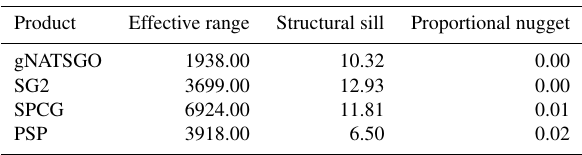
Table 2. Fitted variogram parameters for pH at 0–5cm. The effec- tive range is in metres, the structural sill is in (pH × 10) 2 , and the proportional nugget is [ 0 ... 1 ]